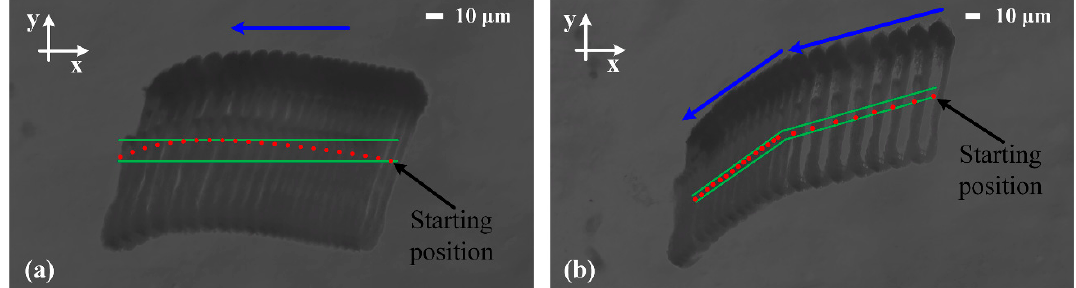
Figure 13. Transportation of the silica rod along different trajectories. ( a ) The particle is moved by 125 µ m along the negative direction of x -axis; ( b ) The particle is first transported along the direction of − 165 ◦ by 98 µ m, and then changed to the direction of − 145 ◦ by 75 µ m. The red dots are the center positions of the particle and the green lines indicate the fluctuation range of the particle center.